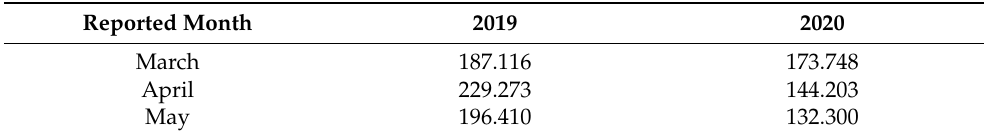
Table 5. Measles-Mumps-Rubella (MMR) vaccines supplies at the end of the months March-April- May 2019–2020 (Vaccine stocks according National Center for Study and Control for Infectious Diseases accessed at: http://cnscbt.ro/index.php/situatia-stocurilor-de-vaccinuri [Romanian] (ac- cessed on 31 July 2022).